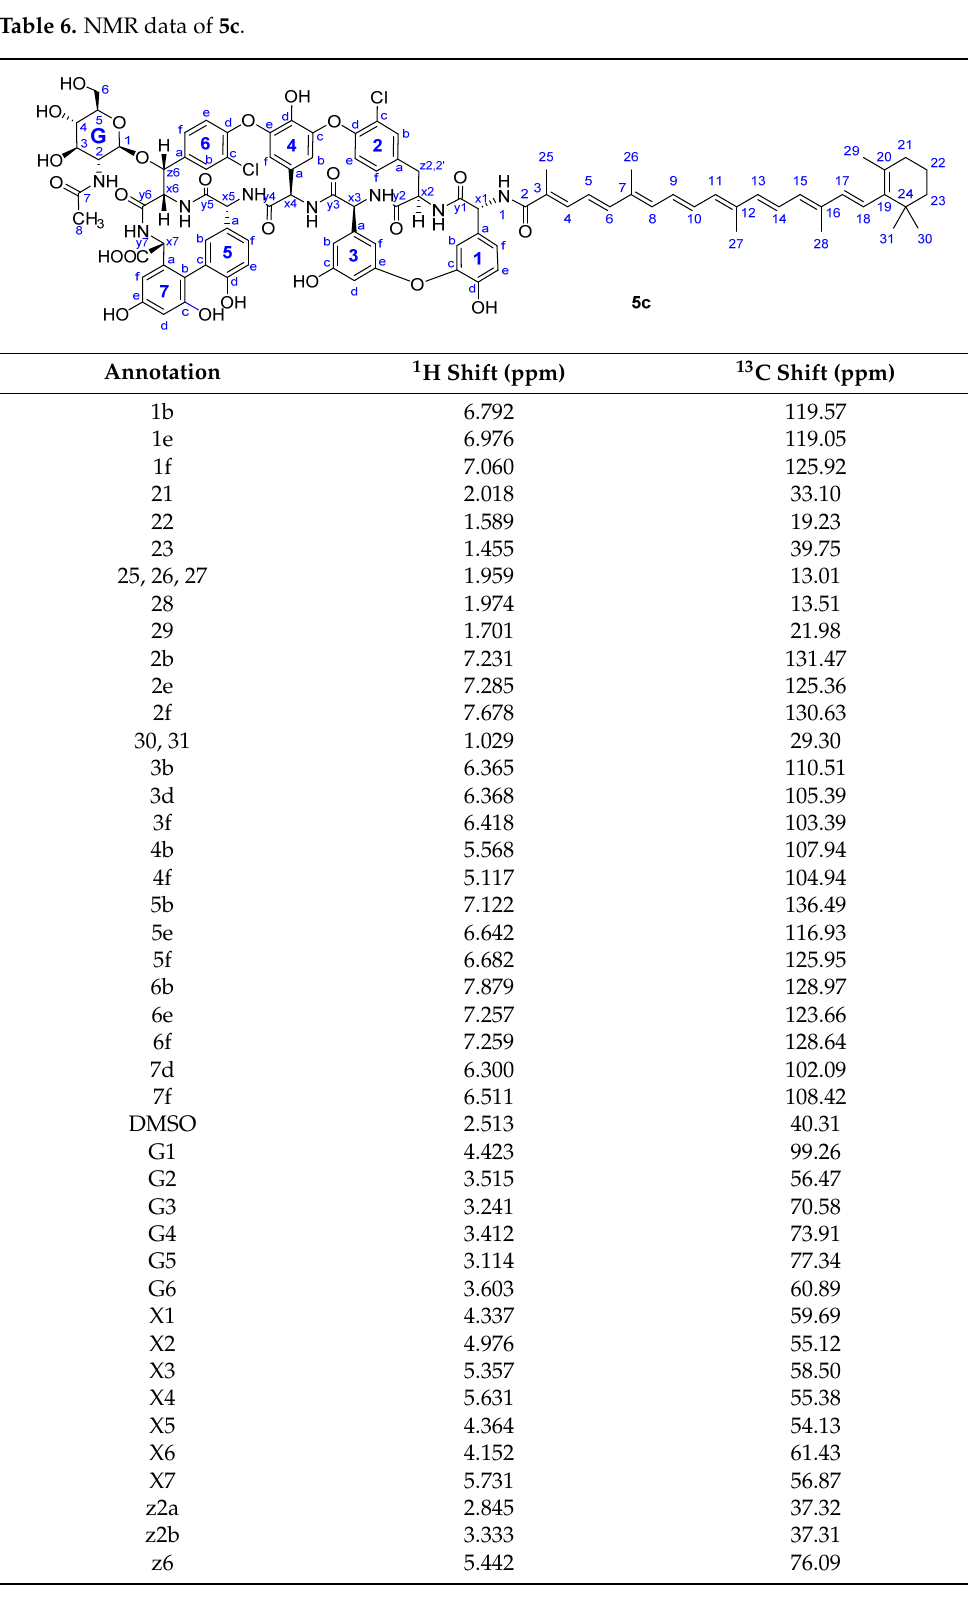
Table 6. NMR data of 5c .